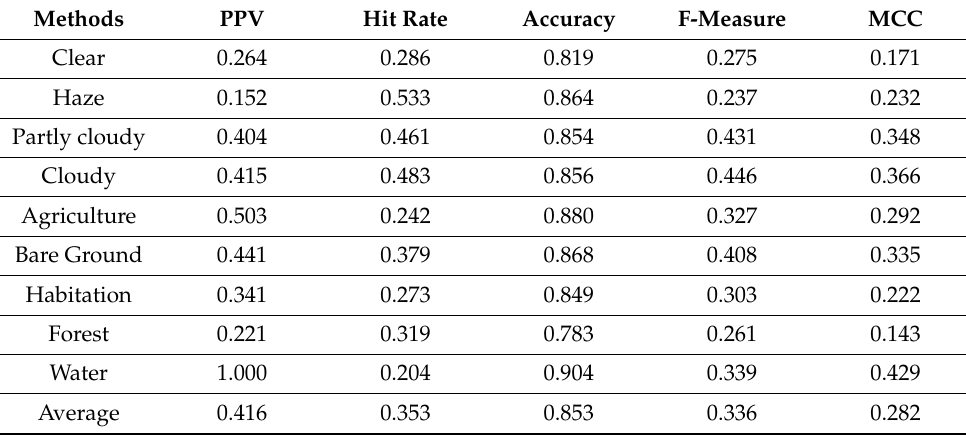
Table 1. Result analysis of VGG-19 model with different measures.